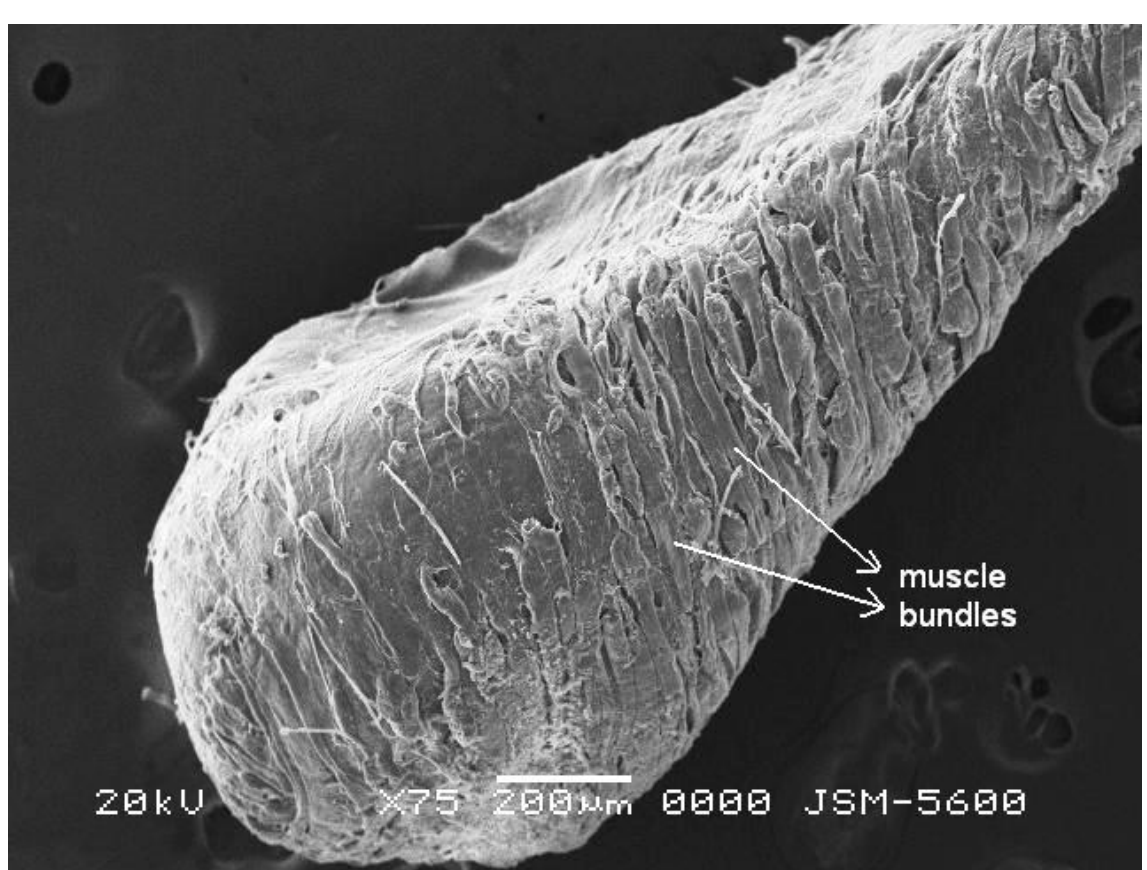
Figure 6. Muscle bundles that cover the venom gland at higher